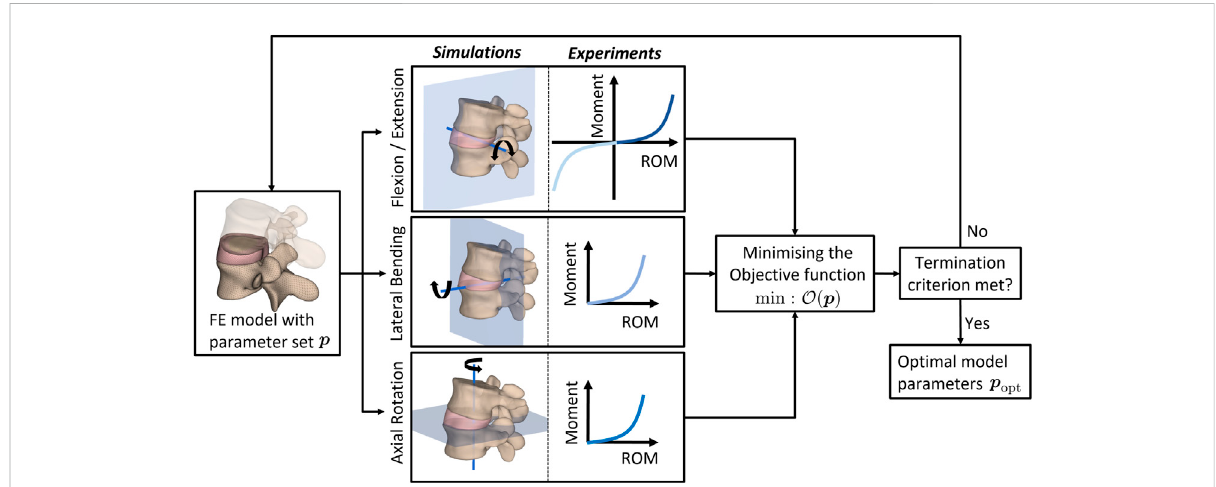
FIGURE 3 Flowchart of the MATLAB-driven inverse-FEM-based optimization algorithm. The material properties characterizing the AF behavior are optimized towards the best agreement between experimental measurements and results of fi nite element simulations emulating the experiments. ROM: range of